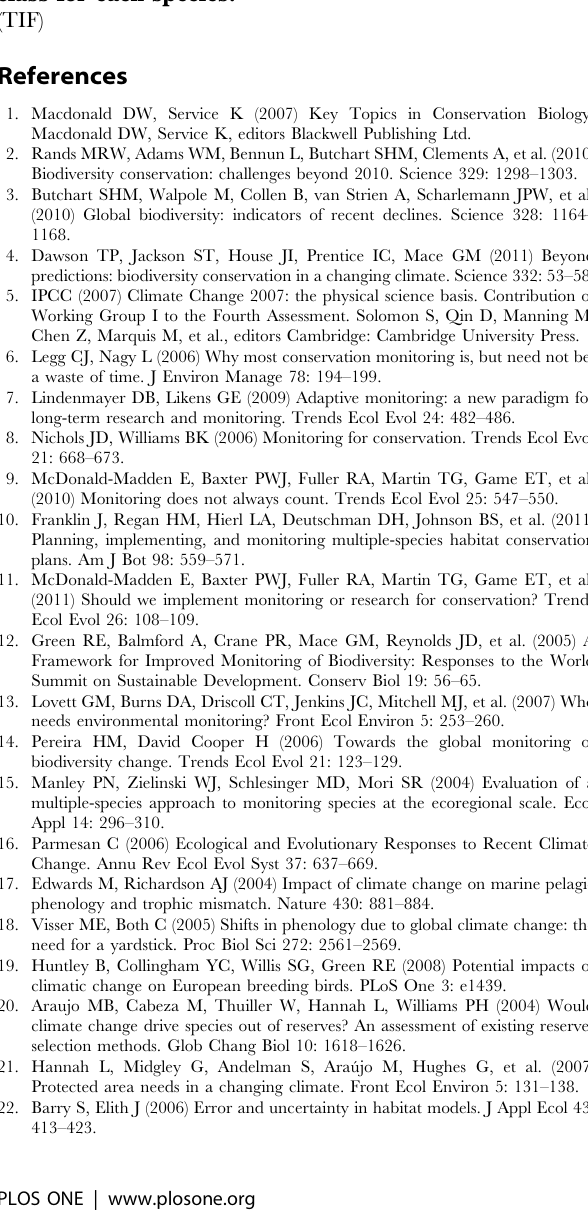
Table S1 AUC values for Training and Test data for both Full and Climatic models. Table S2 Predictor variables by order of relevance for each species for both Full and Climatic models. Table S3 Percentage of the total number of cells that overlap is observed in both Full and Climatic and ENMtools